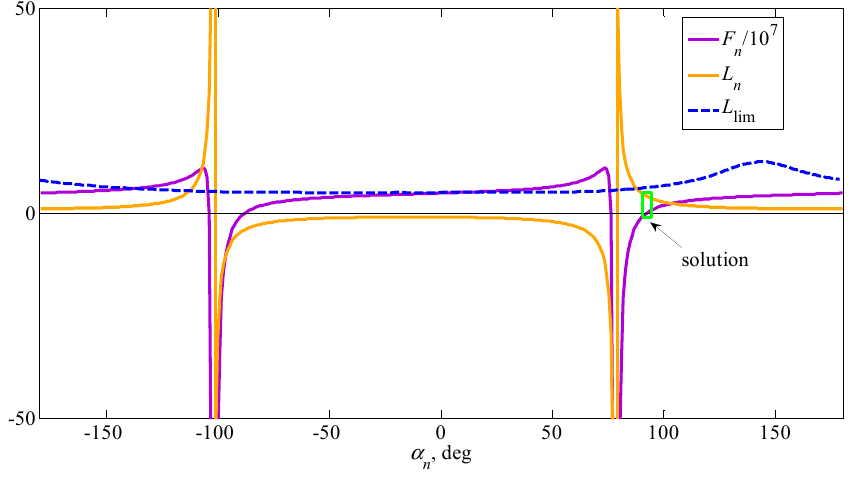
Figure 12. One example of the variation of L n and F n with α n .